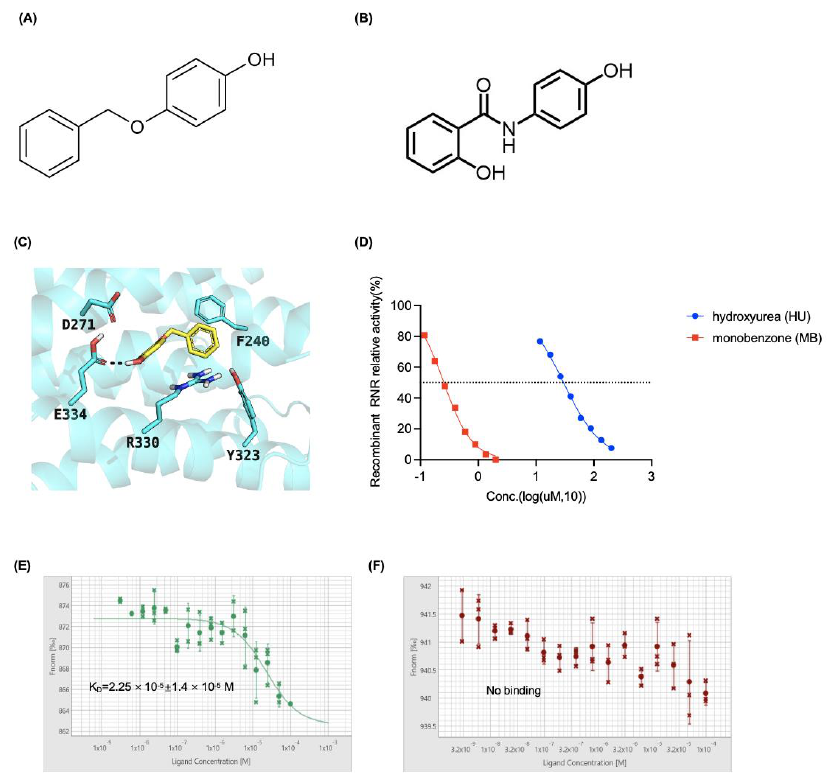
Figure 2 . MB interacted with RRM2 and inhibited the activity of recombinant RNR in vitro. ( A ) Chemical structure of MB. ( B ) Chemical structure of osalmid. ( C ) The 3-dimensional interaction model between MB and RRM2 generated using molecular docking (Glide SP in Schrodinger/2020) showing the interaction between MB and key residues of RRM2 (PDB ID: 3OLJ). MB is represented in yellow sticks. RRM2 helices and residues are presented as a cyan cartoon and cyan sticks, respectively. Hydrogen bonds are represented as purple dashes. ( D ) In vitro recombinant RNR enzymatic assays. HU and MB dose-dependently inhibited the enzyme activity. The solvent DMSO was used as a negative control. ( E , F ) The binding between RRM2 protein and MB and the binding between RRM1 protein and MB were determined by MST assay. Fluorescence intensity and trend, and reproducibility of MST traces were shown. Data shown here are representative of three independent experiments, and the error is calculated as the standard deviation.